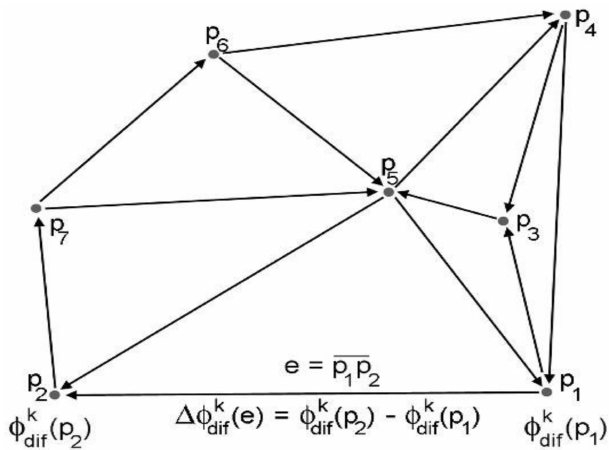
Figure 2. Scheme of the selected pixels